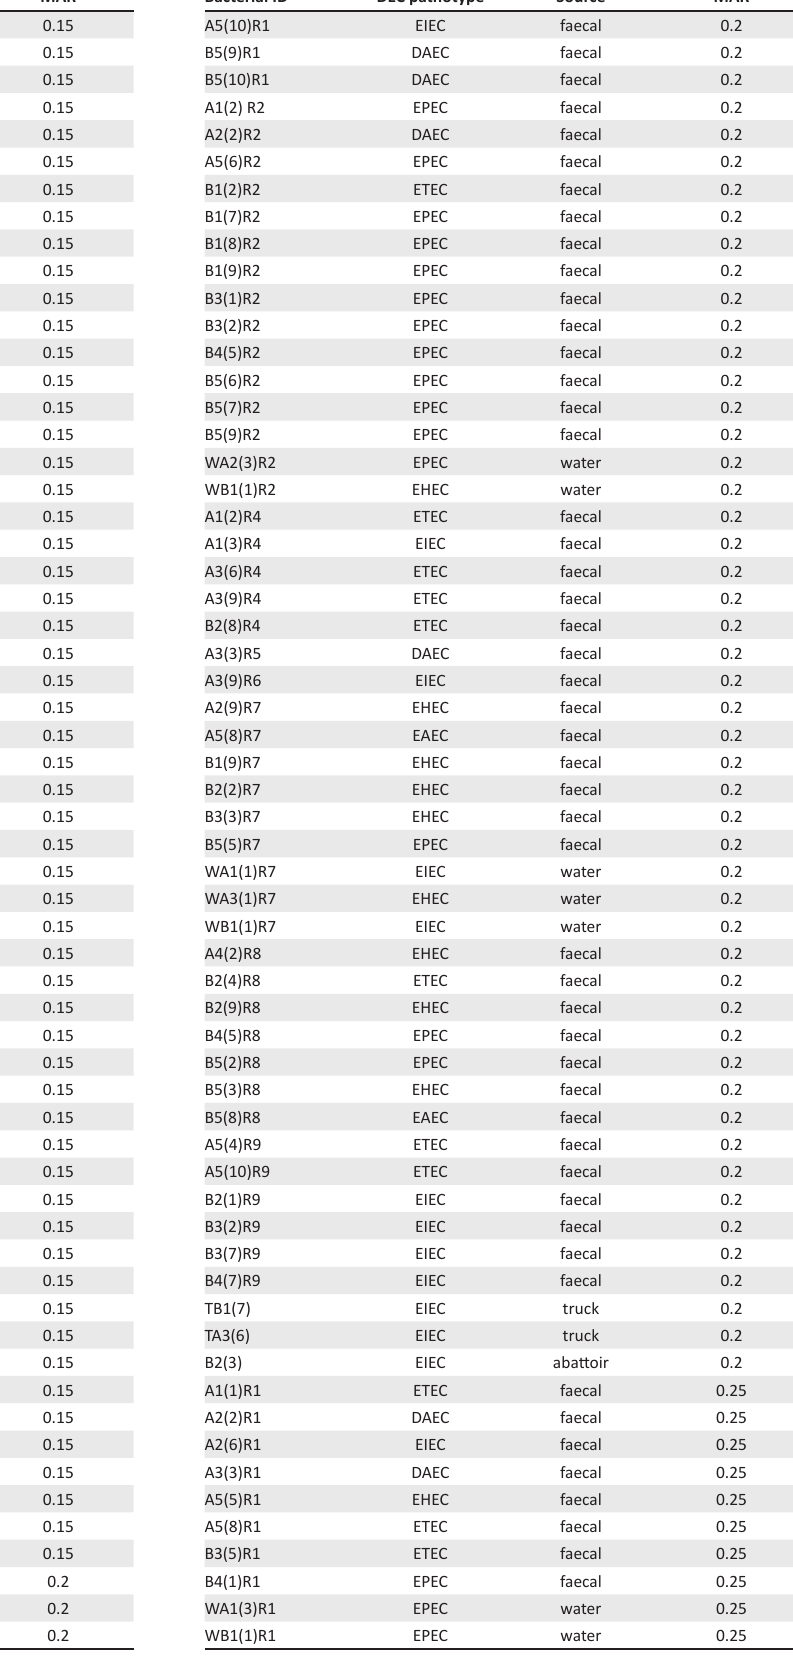
TABLE 4-A1 (Continues...): Multiple-antibiotic resistance index for all diarrheagenic E. coli pathotypes along the farm-to-fork continuum. Bacterial ID DEC